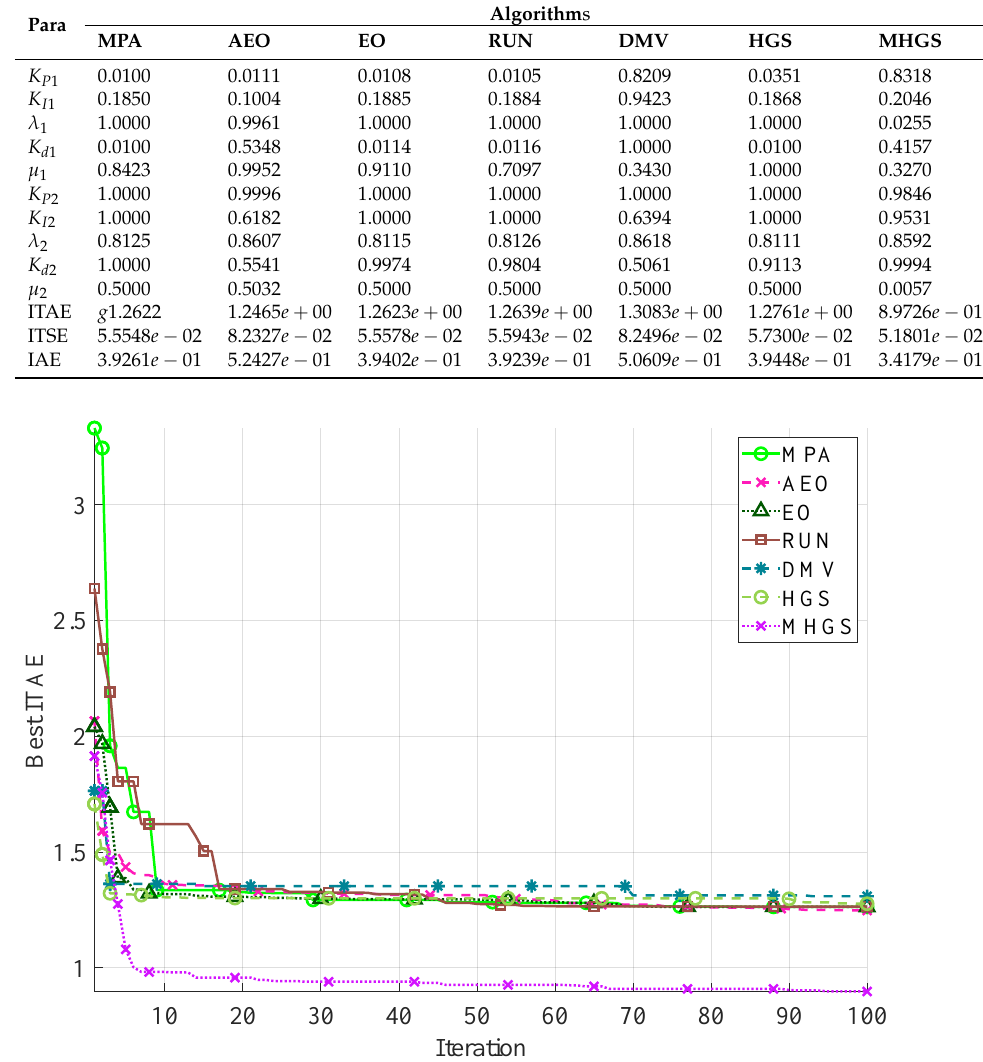
Figure 10. The convergence property of the proposed algorithm and others in the case of PV and thermal plants at 10% load